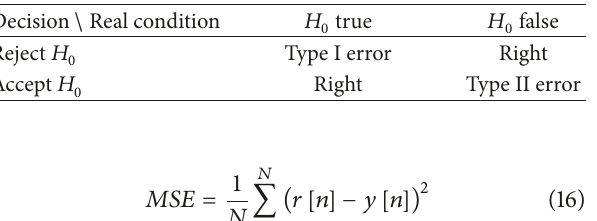
Table 2: Grid power charges. Table 3: Type I and II